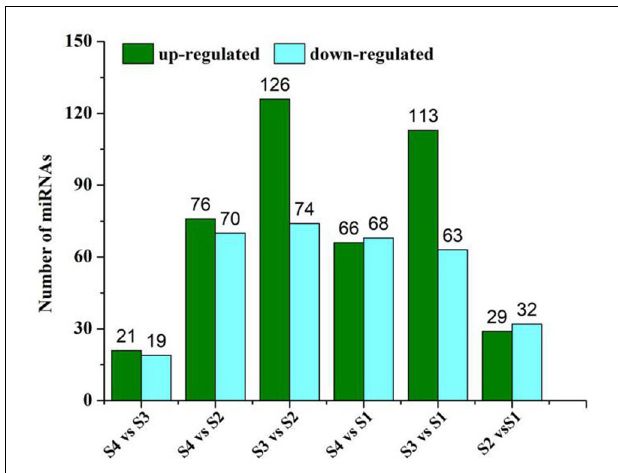
FIGURE 3 | Number of up- and down-regulated miRNAs in different development periods of sesame